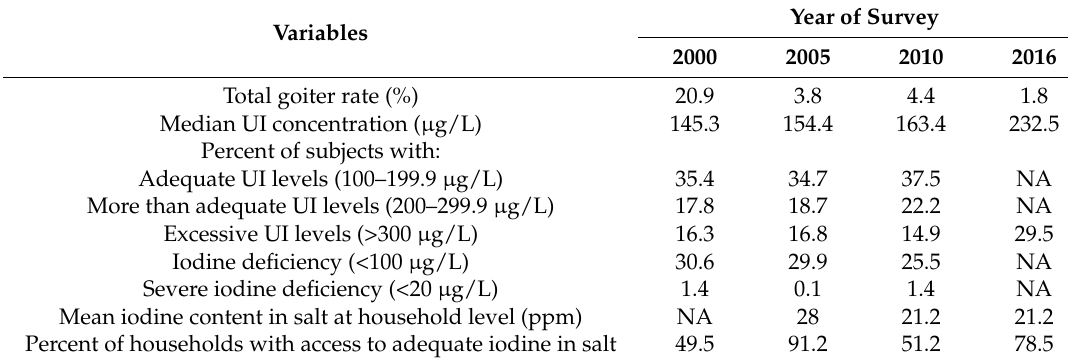
Year of Survey 2000 2005 2010 2016